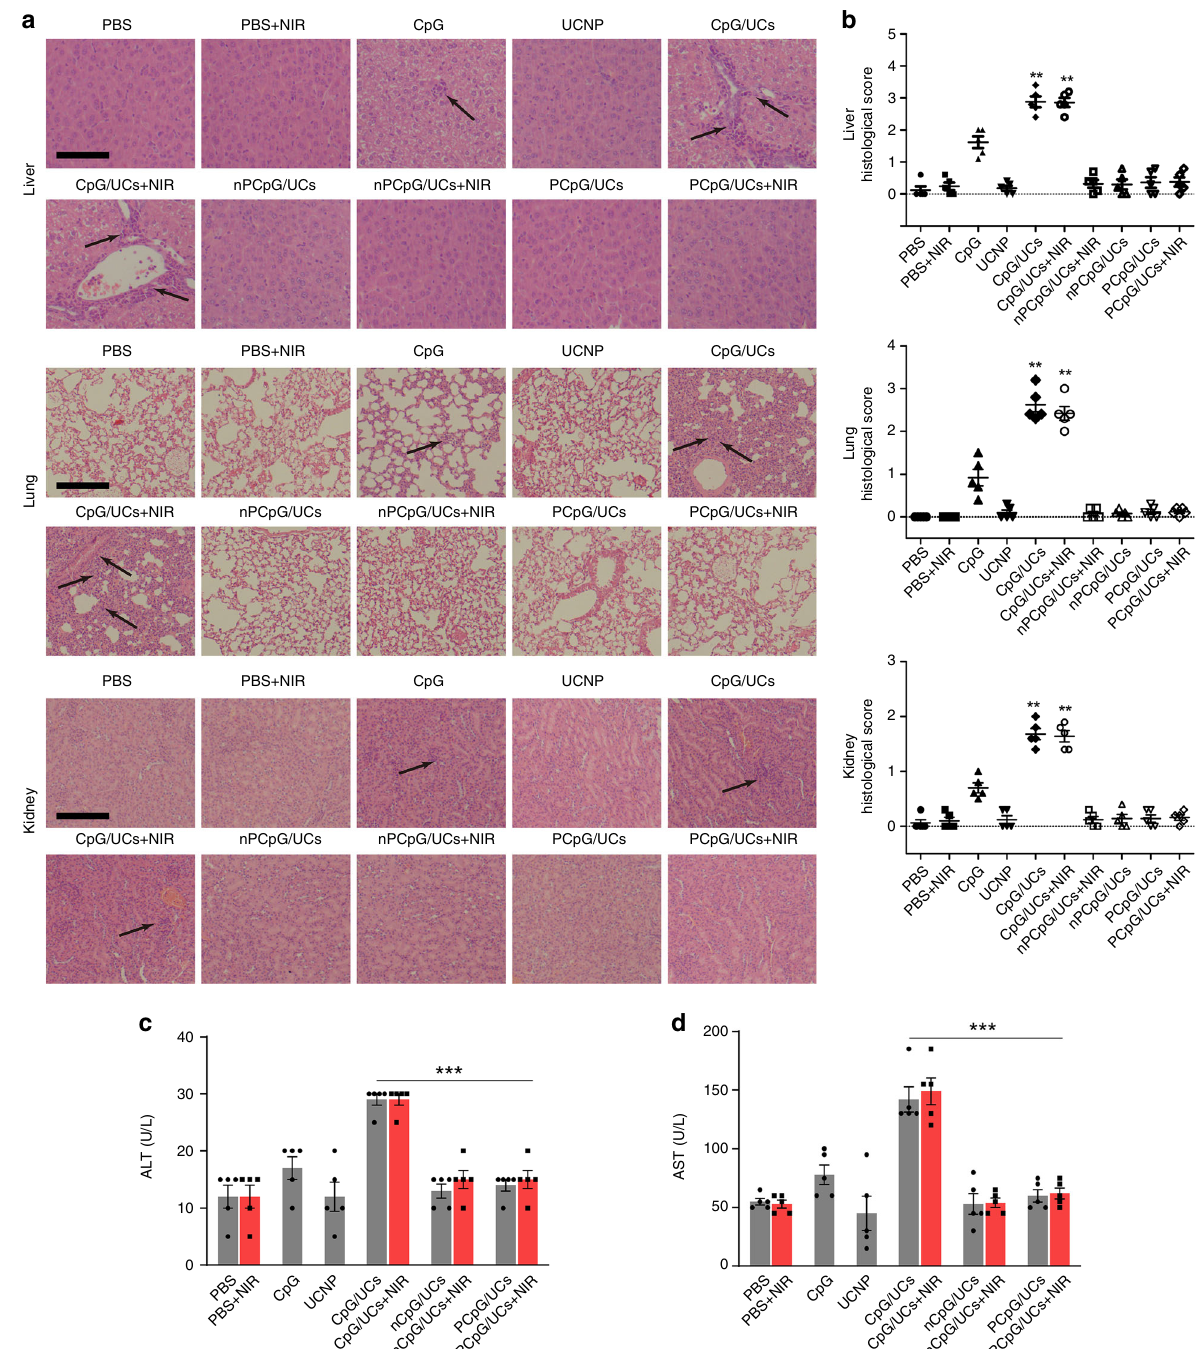
Fig. 6 Photoactivatable immunodevice allows to mitigate systemic toxicity. a Histological assessments of tissues using H&E staining in the different treatment groups. Arrows in liver images indicate the hepatic in fl ammation around portal area. Arrows in lung images indicate the in fl ammatory cell in fi ltration, alveolar swelling and thickening. Arrows in kidney images indicate the kidney in fl ammation. Scale bars, 100 μ m. b Semi-quantitative histological analysis of the H&E-stained tissue sections from different treatment groups. The tissue sections were scored with blinding. The data are presented as the mean ± s.e.m. ( n = 5). * P < 0.05, ** P < 0.01 (one-way ANOVA). c , d Serum ALT and AST levels in the different treatment groups. The data are presented as the mean ± s.e.m. ( n = 4). NS not signi fi cant, * P < 0.05, *** P < 0.001 (one-way ANOVA). Source data are provided as a Source Data fi le T cell in fi ltration in tumor . 4T1 tumor-bearing mice were treated with PBS, CpG, Haematological indices and blood biochemistry . Blood and serum were obtained CpG/UCs, nPCpG/UCs + NIR, PCpG/UCs, PCpG/UCs + NIR (DNA equivalent at day 16 after different treatments. The complete blood counts were analyzed by dose of 100 nmol/kg). Mice were intravenously injected with different samples Celltac MEK-6318K (NIHON KOHDEN, Japan). The serum liver enzymes were every other day for three times. Tumors were immediately disaggregated into tested using automatic biochemical analyzer (Hitachi-7100, Japan). single-cell suspensions (SCSs) 59 . Cells were stained with speci fi c antibodies for analysis of CD4 + T, CD8 + T cells, and Tregs in tumors using Gallios Flow Histological examination . Isolated xenografted organs (hearts, spleens, lungs, cytometry (Beckman Coulter, USA). livers, and kidneys) and tumors were fi xed with 4% paraformaldehyde for 24 h. NATURE COMMUNICATIONS| (2019) 10:2839